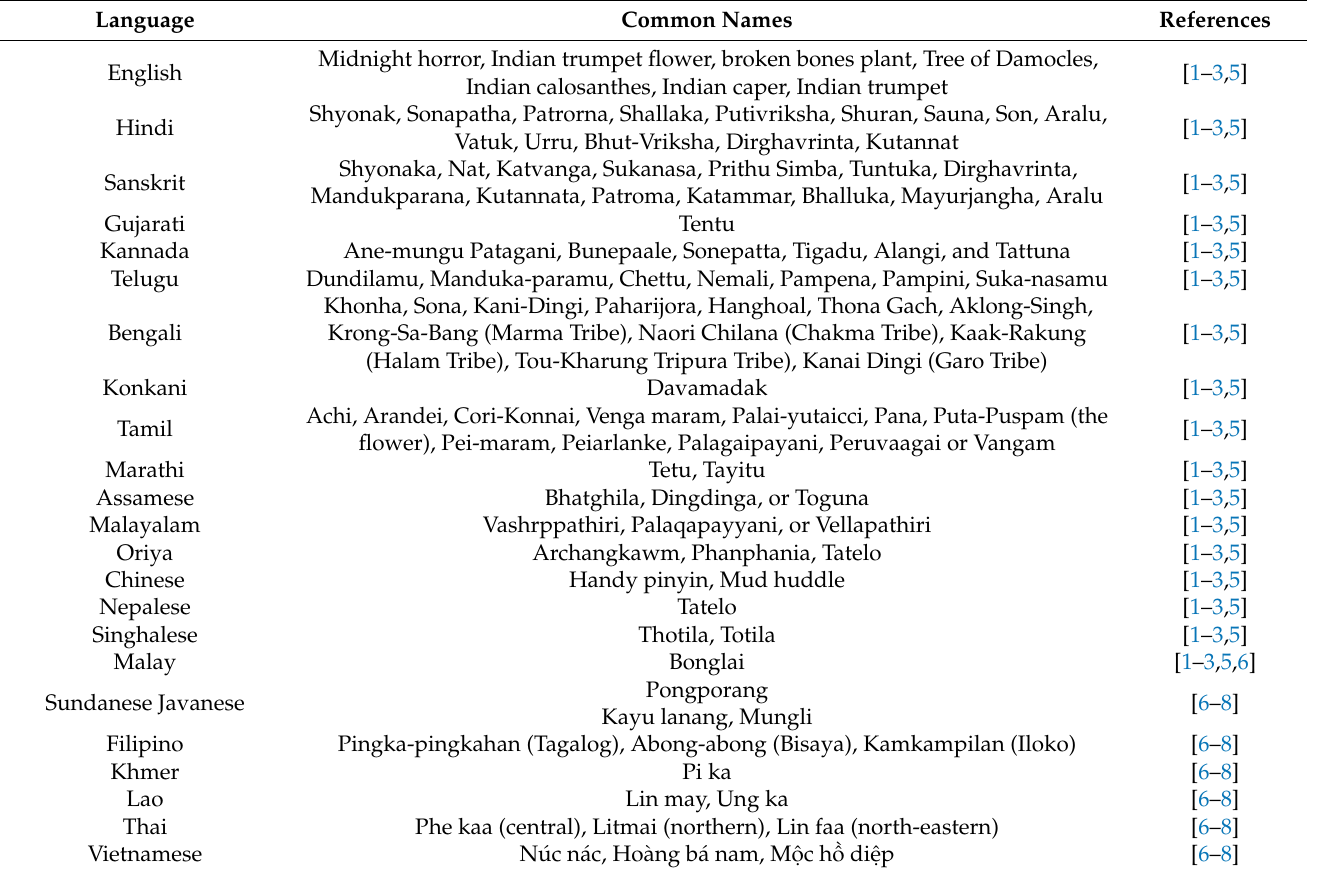
Table 1. Common names of Oroxylum indicum in different